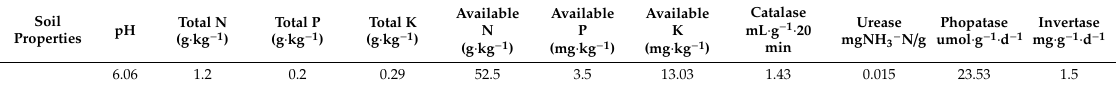
Table 1. Initial chemical composition and soil enzyme activity of the tested soil samples. Soil